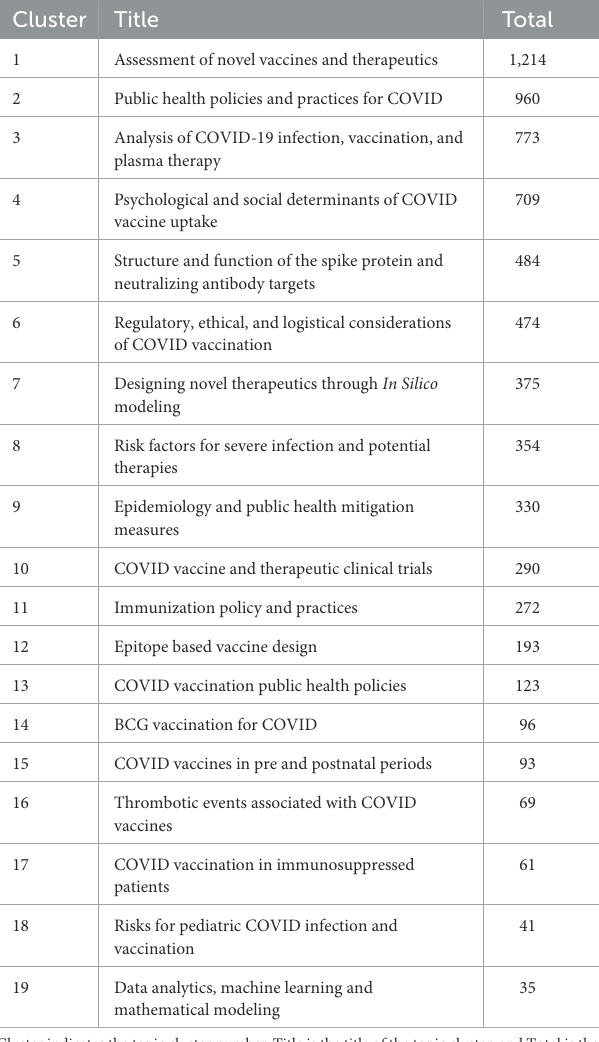
TABLE 1 Identification of major topic areas in COVID-19 vaccine-related